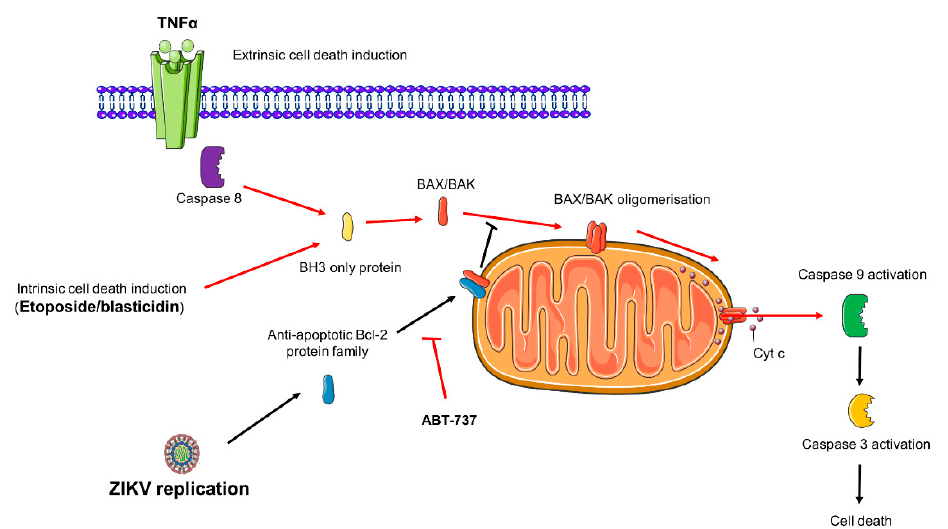
Figure 9. Model depicting the protective action of ZIKV infection against apoptosis. Intrinsic or extrinsic activation of cell death occurs through the formation of mitochondrial outer membrane pore (MOMP) via the BAX / BAK complex. The anti-apoptotic family Bcl-2 members Bcl-2 / Bcl-XL interfere with the complex formation by sequestering BAX via their BH3 domain. ZIKV replication interferes with BAX relocalization at the mitochondria. ABT-737, a BH3 mimetic, which inhibits Bcl-2 / Bcl-XL, abrogates the inhibition induced by ZIKV. Indeed, the virus delays apoptosis during infection by modulating the homeostasis of Bcl-2 / Bcl-XL.